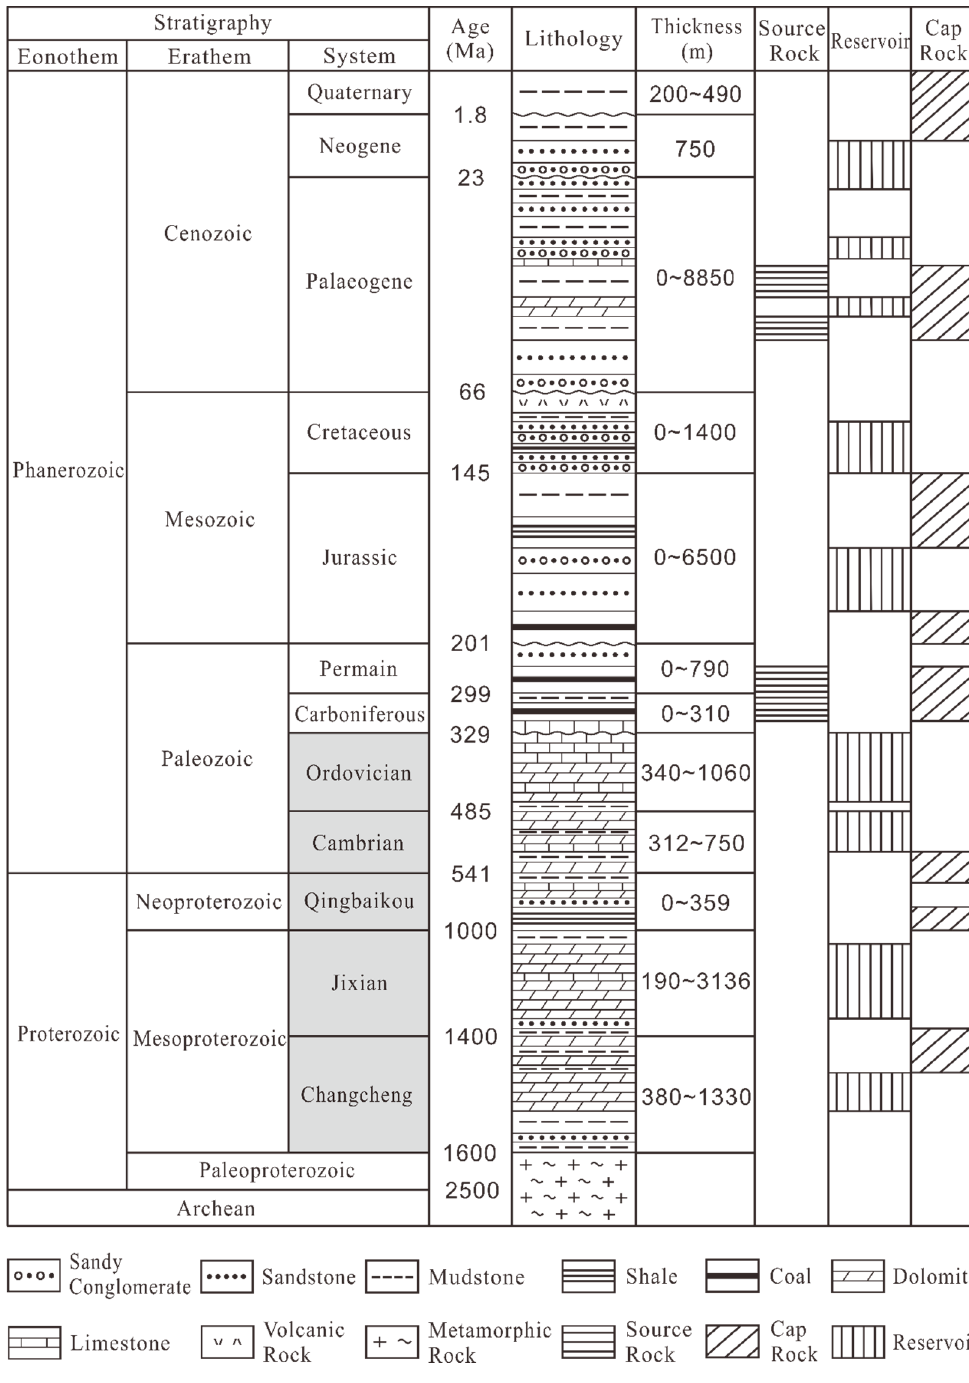
Figure 3. The stratigraphic column of the Jizhong Sub-Basin, showing the major petroleum systems (source rocks, reservoirs, and cap rocks) (modified according to Wu et al., 2011, and Liu et al., 2017) [19,37]. The gray mark in the system is the target layer of this